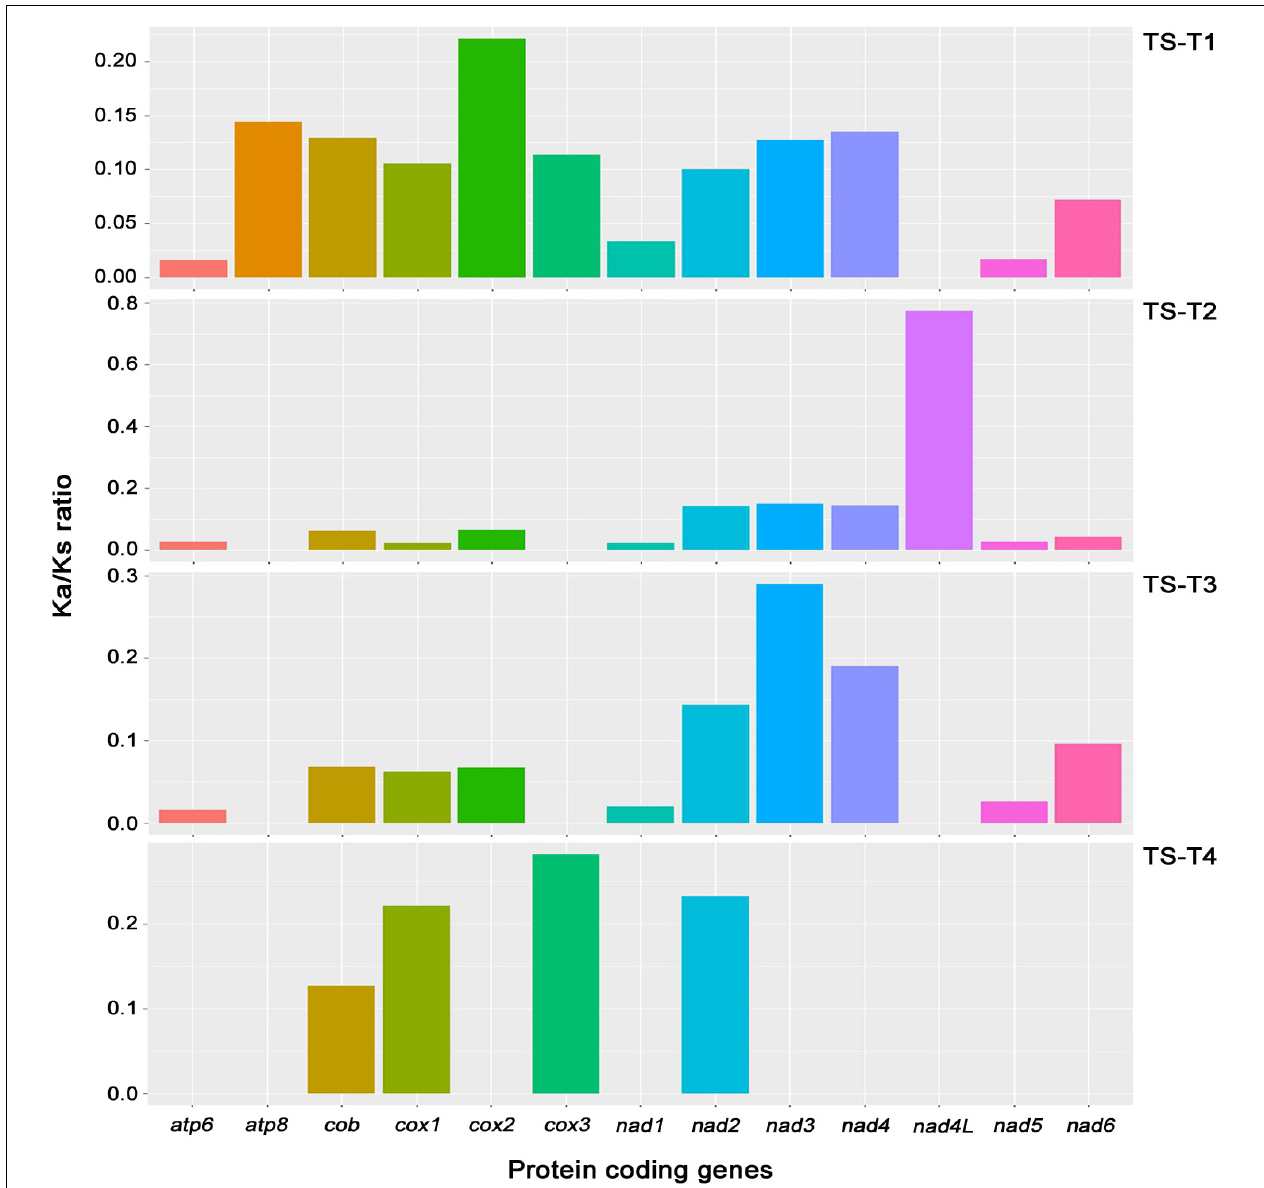
FIGURE 4 | Analysis of Ka/Ks ratios for 13 core genes of the T. atroviride ATCC 26799 mitochondrial genome. Obtained values for Ka/Ks ratios were described in Supplementary Table S6 . Ka, nonsynonymous substitution rate; Ks, synonymous substitution rate; TS-T1, pairwise alignment between T. atroviride ATCC 26799 (TS) and T. reesei QM9414 (T1); TS-T2, pairwise alignment between T. atroviride ATCC 26799 (TS) and T. asperellum B05 (T2); TS-T3, pairwise alignment between T. atroviride ATCC 26799 (TS) and T. hamatum (T3); TS-T4, pairwise alignment between T. atroviride ATCC 26799 (TS) and T. gamsii KUC1747